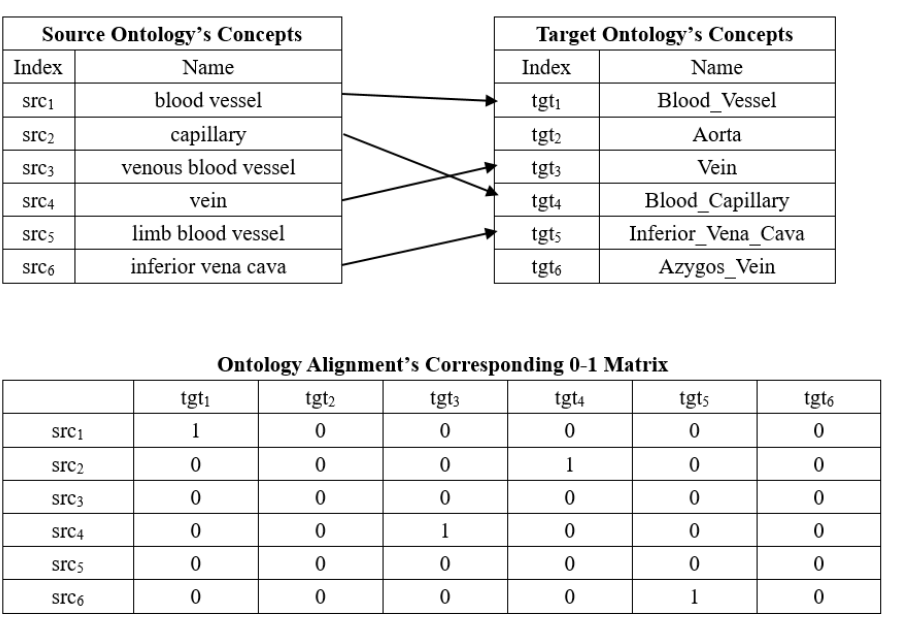
Figure 1. An example of the biomedical ontology alignment and the corresponding 0–1